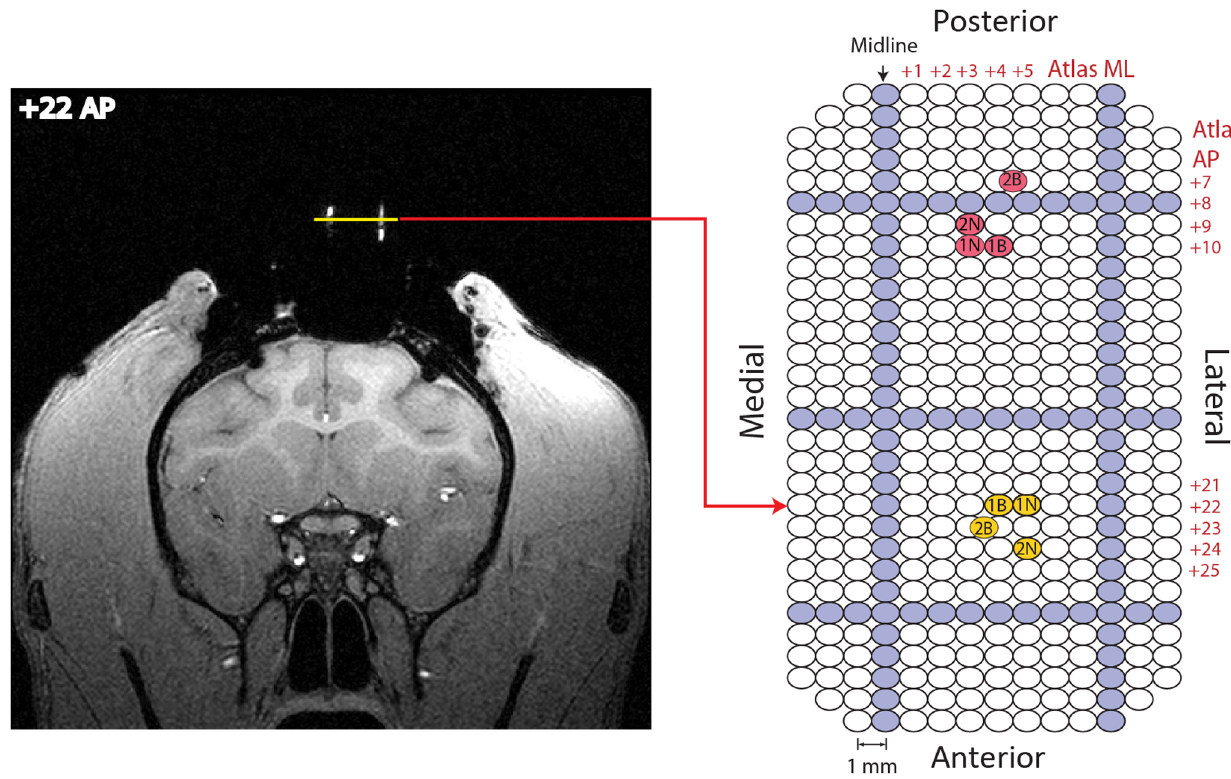
Figure 2. Location of stimulation and recording sites. A grid with 1 mm 6 1 mm spacing (see Fig. 1) was filled with a contrast agent to align T1- weighted structural MRIs with the coordinate system of the recording chamber. The same grid could be offset by 0.5 mm in the mediolateral (ML) axis, so some penetrations occurred half way between adjacent ML holes in this figure. Left: Frontal MRI section that best matches atlas coordinate AP 22 in monkey B. The horizontal line above the brain is parallel to the plane of the recording chamber. It intersects with two of the filled grid holes, which appear as vertical lines. The distance between the filled grid holes is 8 mm. Right: Map of grid holes used for recording and stimulation. Darker rows indicate holes filled with contrast agent for MRI in monkey B. An arrow shows best AP correspondence with MRI to the left. The AP and ML atlas coordinates of each hole are shown alongside the grid for select grid locations, so that results from both monkeys can be shown here on a common grid map. Example VTA/SNc stimulation (posterior group) and matching FSCV recording (anterior group) sites are plotted on the grid. Matching sites have the same letter/number designation. Letter designates monkey B or N. Table 1 shows the depths of the labeled sites.